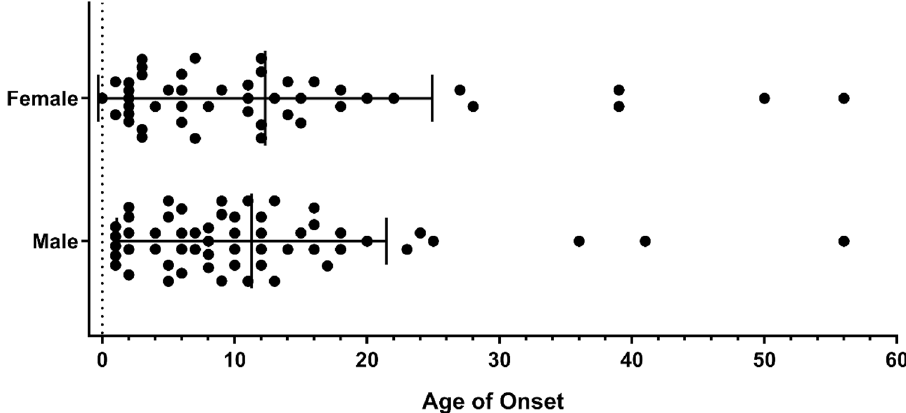
Figure 1. Age distribution of CVID onset by gender for the study group (The figure was created using GraphPad Prism version 7.0.0 for Windows, GraphPad Software, San Diego, California USA, www. graph pad.